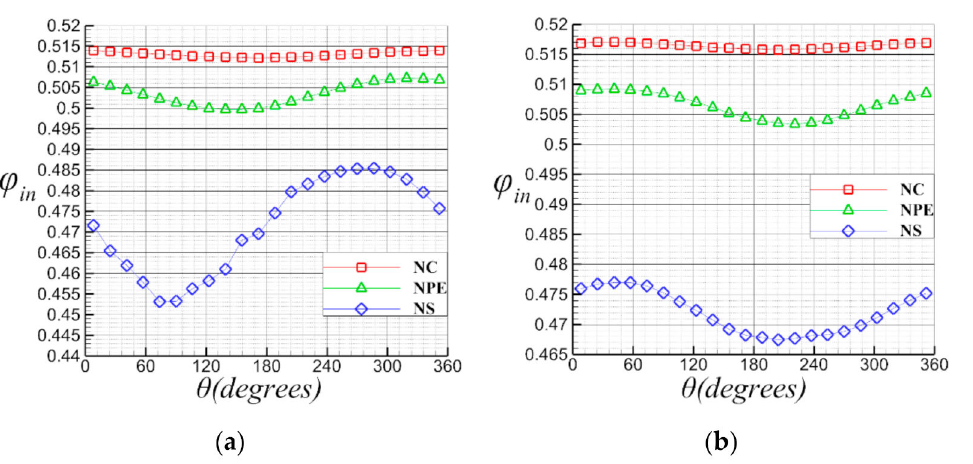
Figure 15. Distribution of inlet flow coe ffi cient along the circumference in the case of 80% eccentricity. ( a ) Steady CFD result; ( b ) unsteady CFD